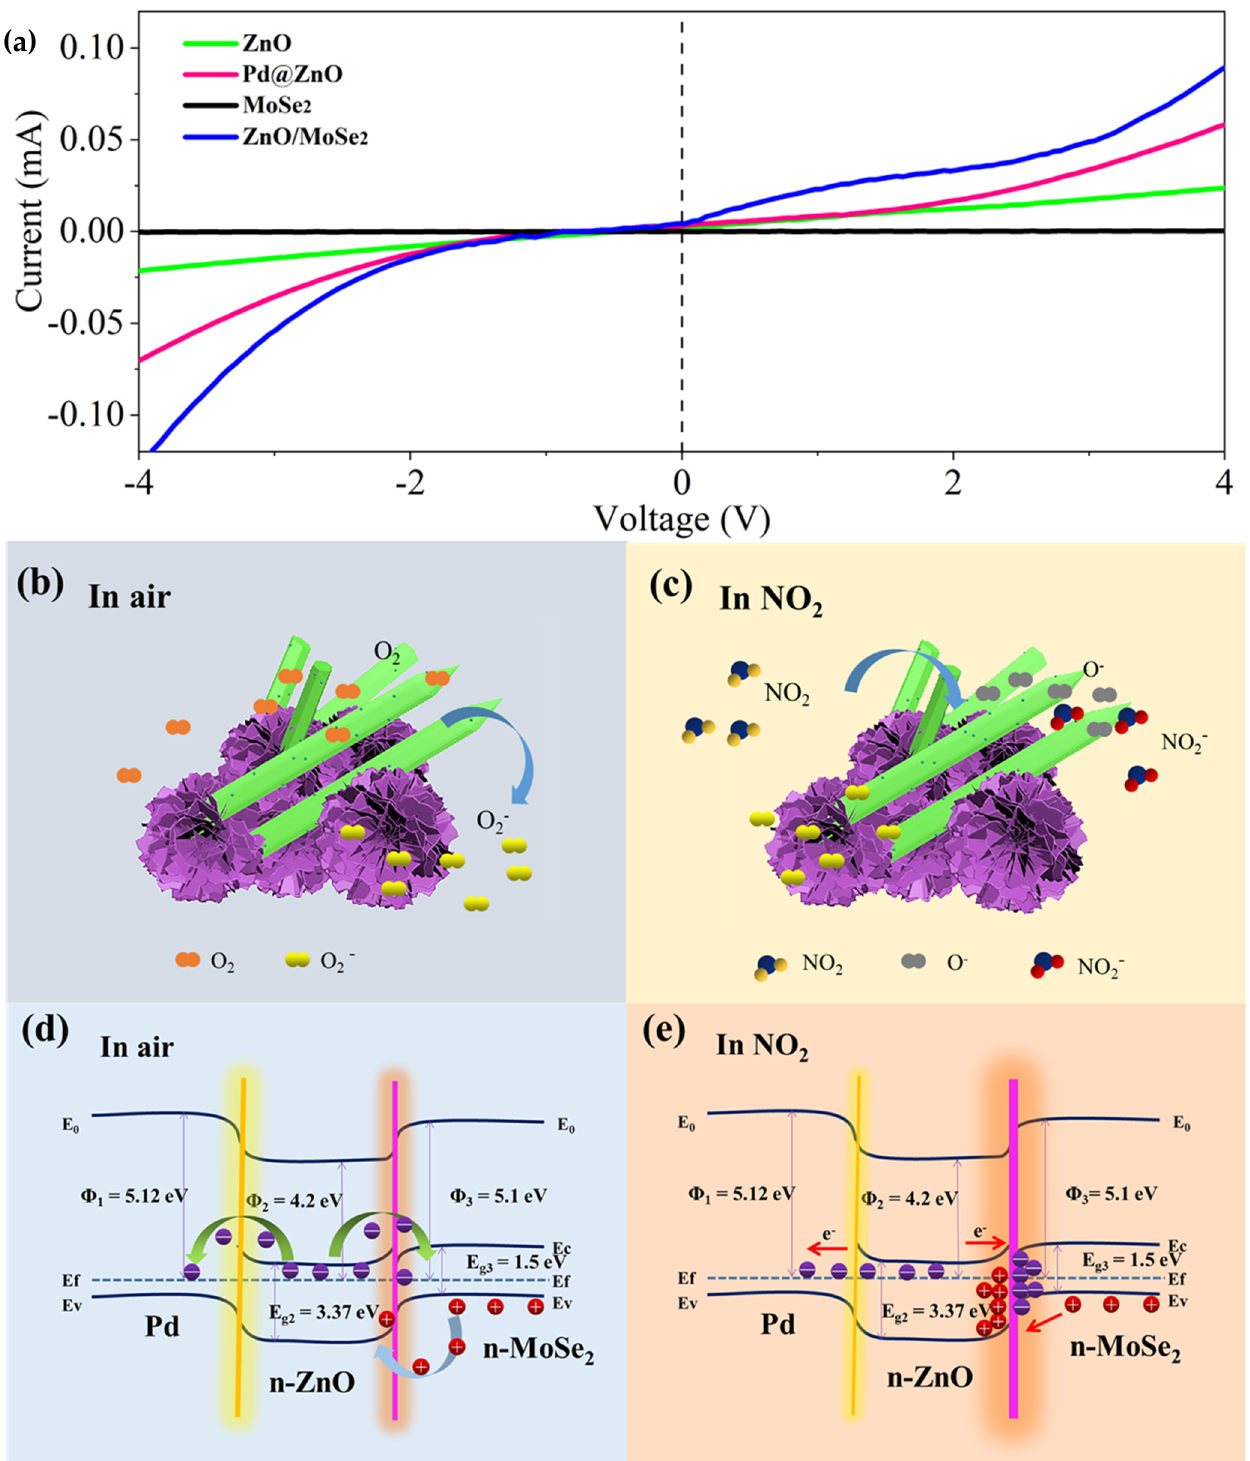
Figure 8. ( a ) I–V curve of ZnO, MoSe 2 , Pd@ZnO and ZnO/MoSe 2 at 25 °C. ( b , c ) Gas-sensing mecha- nism of Pd@ZnO/MoSe 2 composites in air and NO 2 . ( d , e ) Energy band structure of Pd@ZnO/MoSe 2 composites in air and NO 2 (E f , Fermi-energy level; E C , conduction band; E V , valence band; φ , work function).